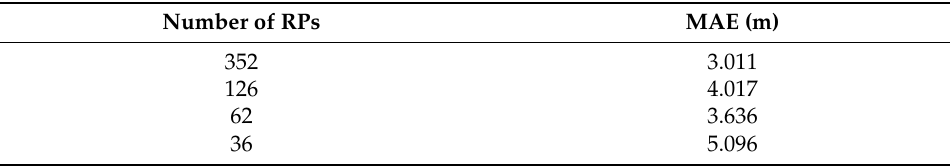
Table 2. The MAEs of positioning method with different number of RPs.